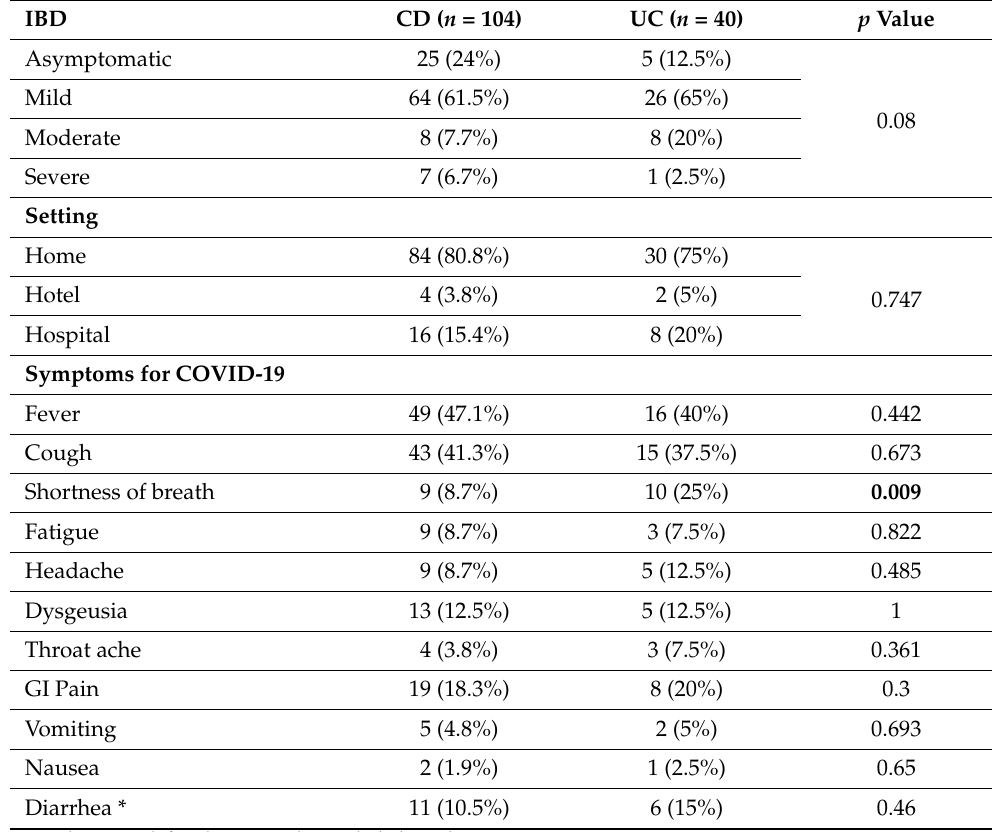
Table 3. COVID-19 characteristics according to CD and UC